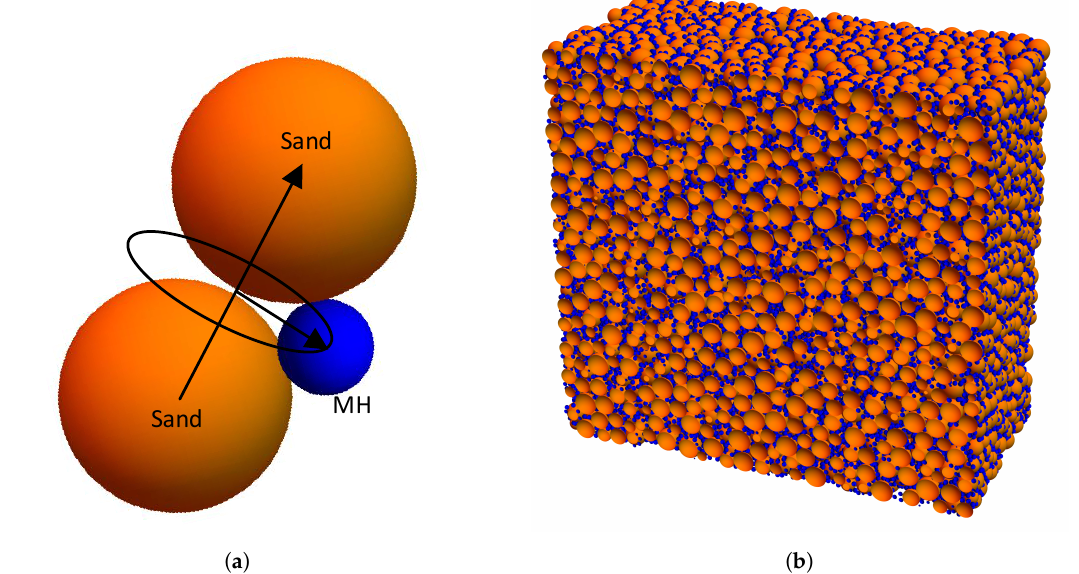
Figure 6. Hydrate seeding procedure: ( a ) schematic seeding position of a single methane-hydrate (MH) particle; ( b ) a typical MH cube sample (cross-section at the middle of a cube).